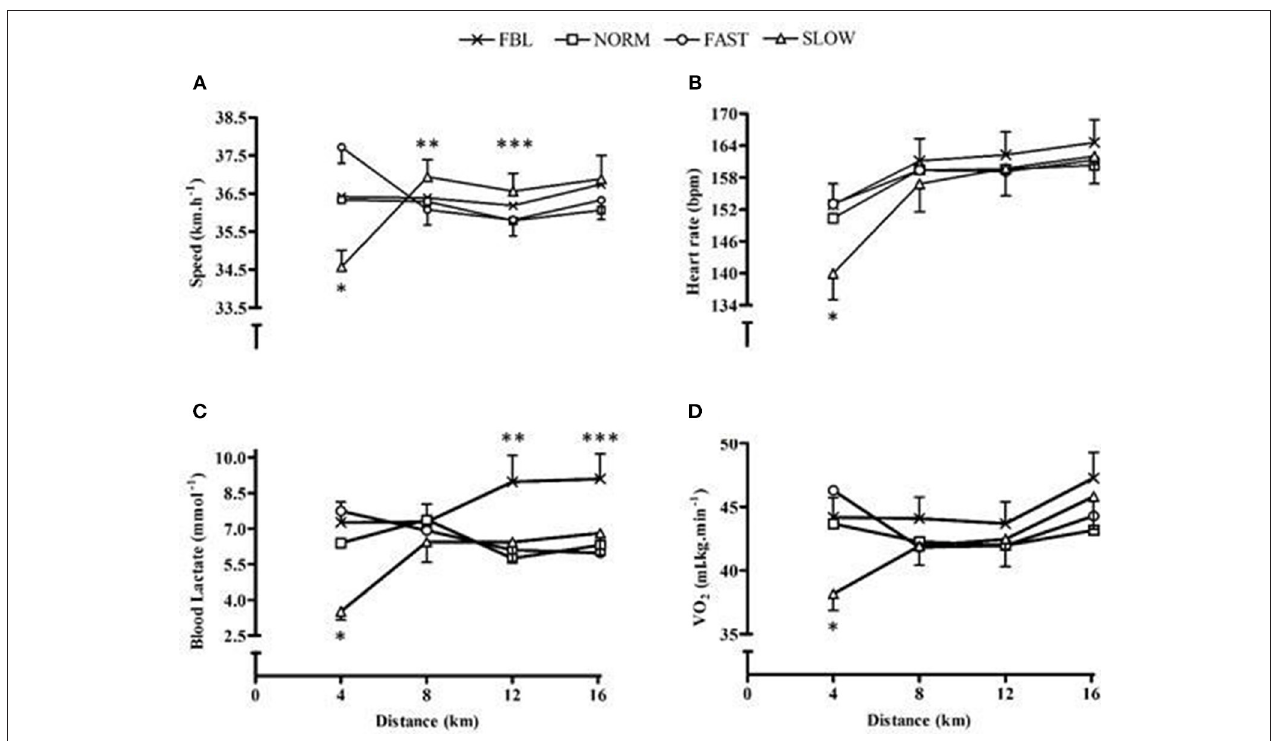
FIGURE 1 | Whole-trial mean and SEM physiological responses for each condition across distance quartiles, illustrating significant interaction effects. (A) Speed *denotes SLOW significantly slower than both FBL and FAST ( p ≤ 0.018), **denotes SLOW significantly faster than FAST ( p = 0.028), ***denotes SLOW significantly faster than both NORM and FAST ( p ≤ 0.01); (B) Heart rate, *denotes significantly lower heart rate in SLOW than all other conditions ( p ≤ 0.001); (C) Blood lactate, * denotes significantly lower values during SLOW than all other conditions ( p ≤ 0.02), ** denotes significantly higher values in FBL than all other conditions ( p ≤ 0.04), ***denotes significantly higher values in FBL than NORM ( p = 0.02); (D) ˙VO 2, *denotes significantly lower ˙VO 2 during SLOW than FBL and NORM ( p ≤